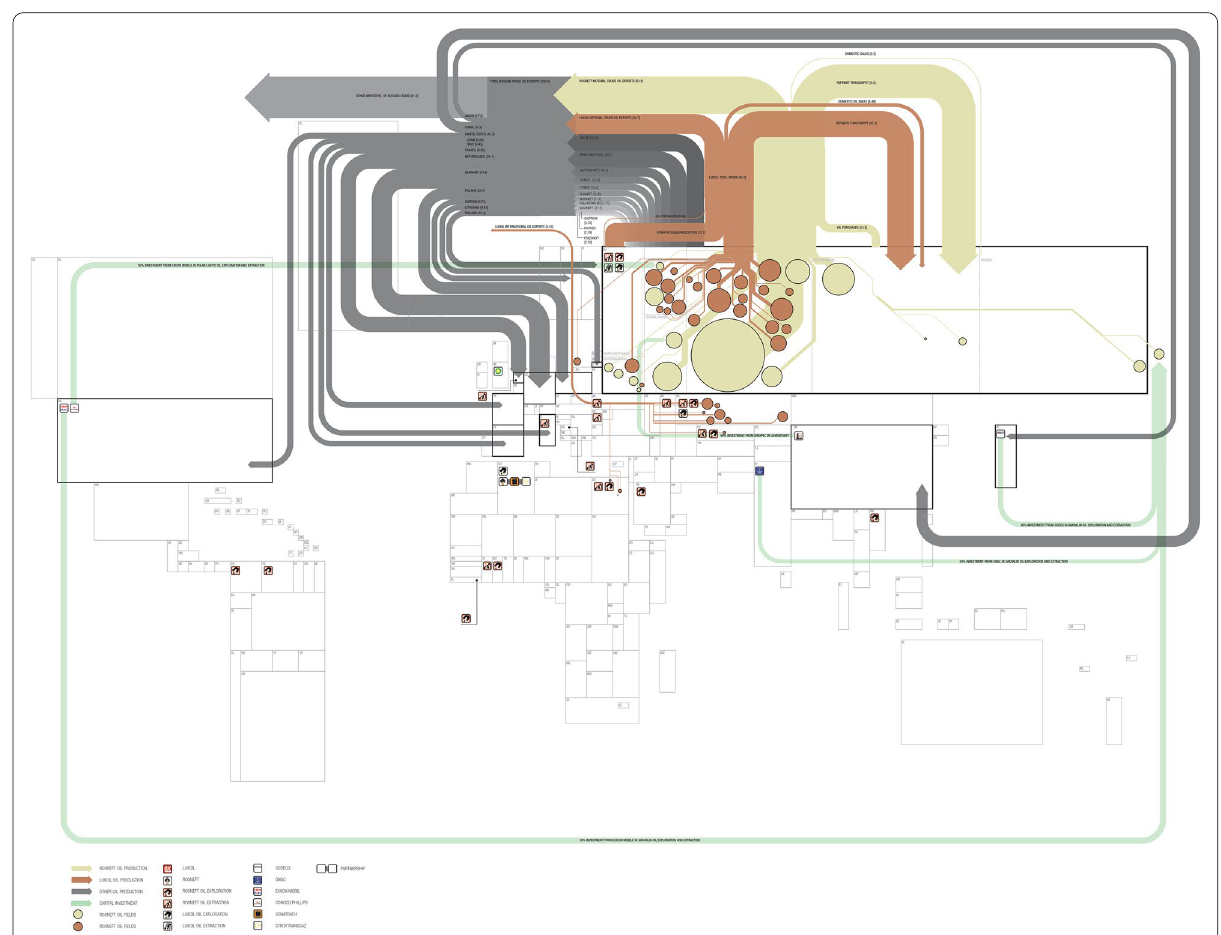
Fig. 6 ROSNEFT’s and LUKOIL’s capital and production flows. Image credits: Salgueiro Barrio and O’Shea. Refer Fig.